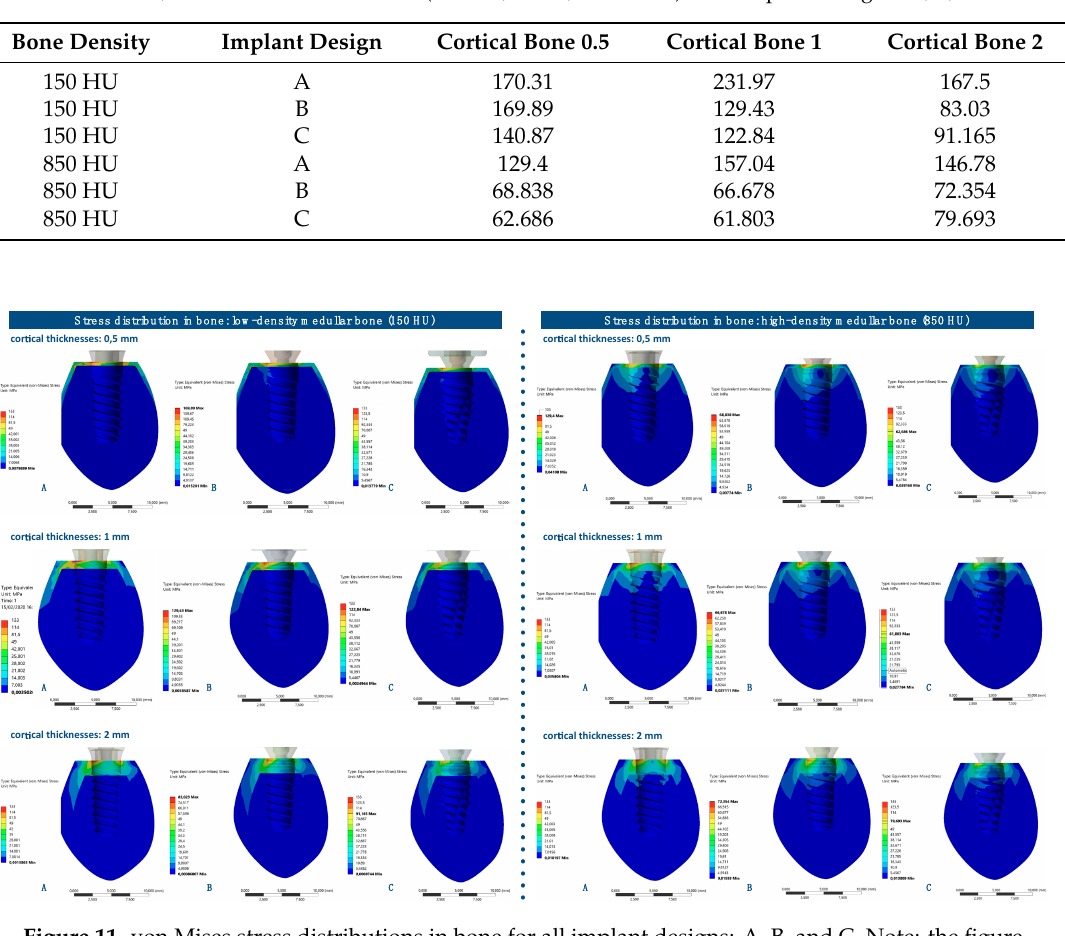
Figure 11. von Mises stress distributions in bone for all implant designs: A, B, and C. Note: the figure is in very high resolution to be able to be enlarged: enlarge it in your word processor or view it in HTML